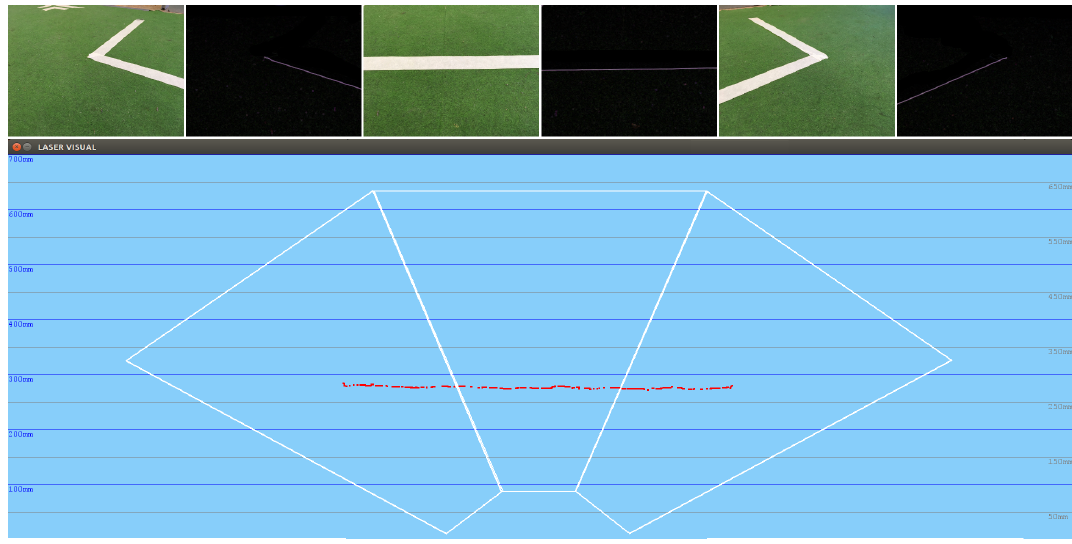
Figure 15. Distance estimation accuracy: getting a complete straight line.